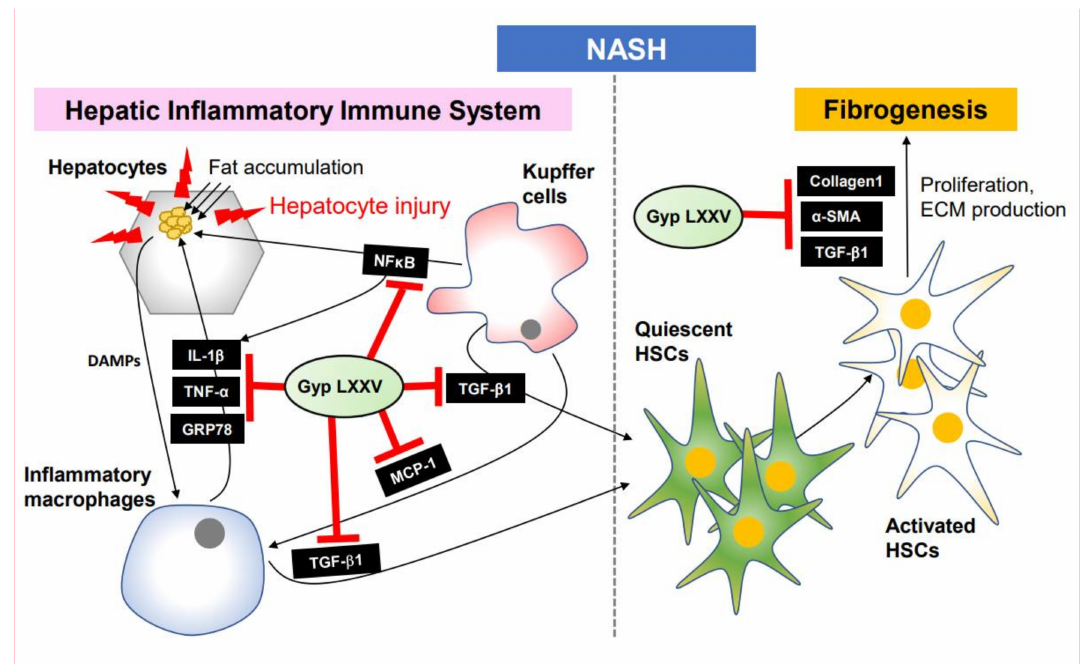
Figure 9. Schematic hepatic inflammation-dependent regulatory mechanism of Gyp LXXV against non-alcoholic steatohepatitis